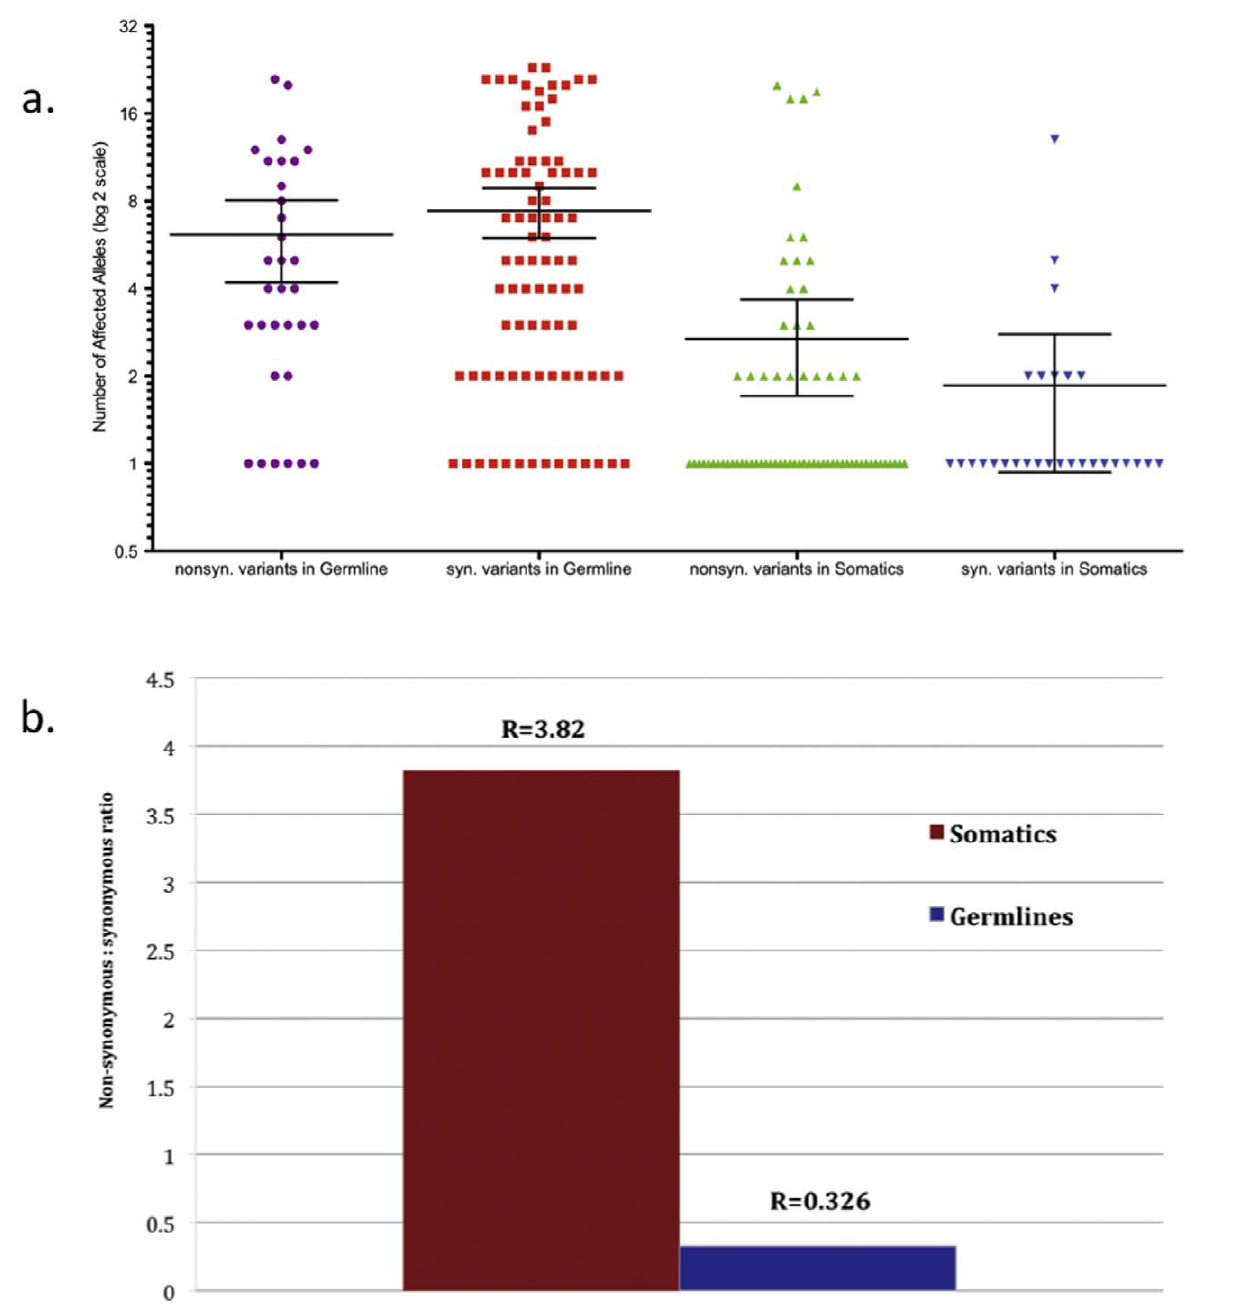
Figure 1. Distribution of allele frequencies of non-synonymous and synonymous germline and somatic variants in melanoma patients. (a) Allele frequencies of germline and somatic variants. The mean allele frequencies were: higher for germline variants (ns=6.125, s=7.412) than for the somatic variants, (ns=2.685, s=1.857). (b) Comparison of the ratios of non-synonymous to synonymous germline and somatic variants. Both were significantly different from the 2:1 ratio expected by chance alone, but in opposite directions (somatic, binomial p=1.15354 6 10 2 5 ; germline binomial p=6.3953 6 10 2 126 ).